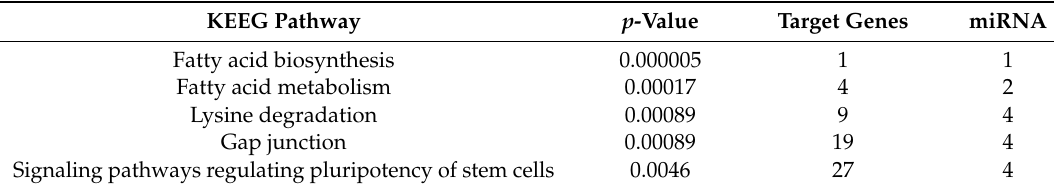
Table 2. Detected miRNA number for di ff erential expression